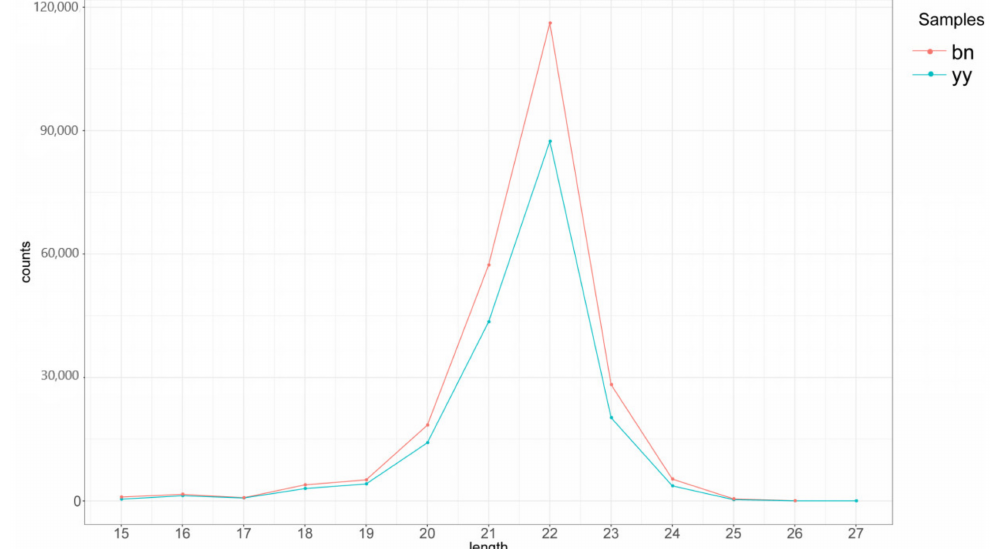
Figure 1. Known miRNA length distribution of P. cristata . Green represents vegetative cells (yy) and red indicates dormant cysts (bn). Table 2. Distribution of reads in the libraries of vegetative cells (yy) and dormant cysts (bn).